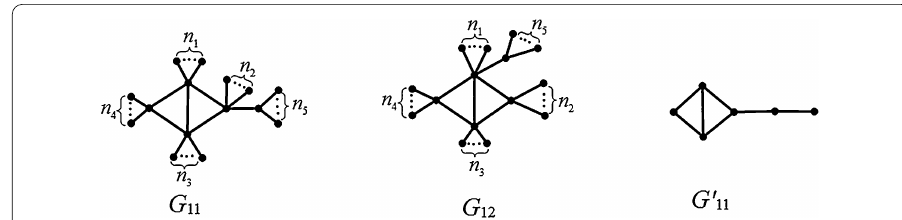
Figure 11 Some bicyclic graphs with θ (2,3,3) as their kernel.